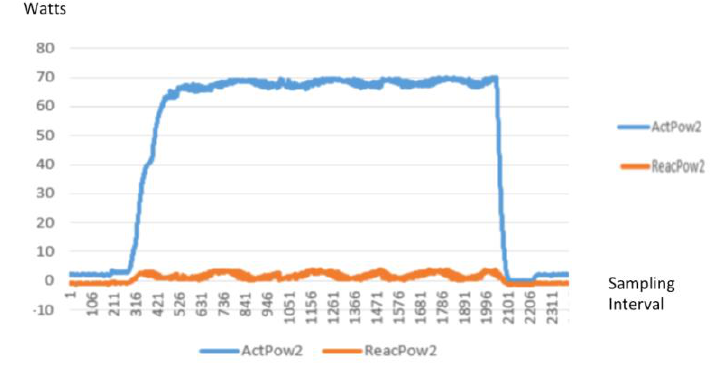
Figure 8. Power (W) signature of an air purifier.